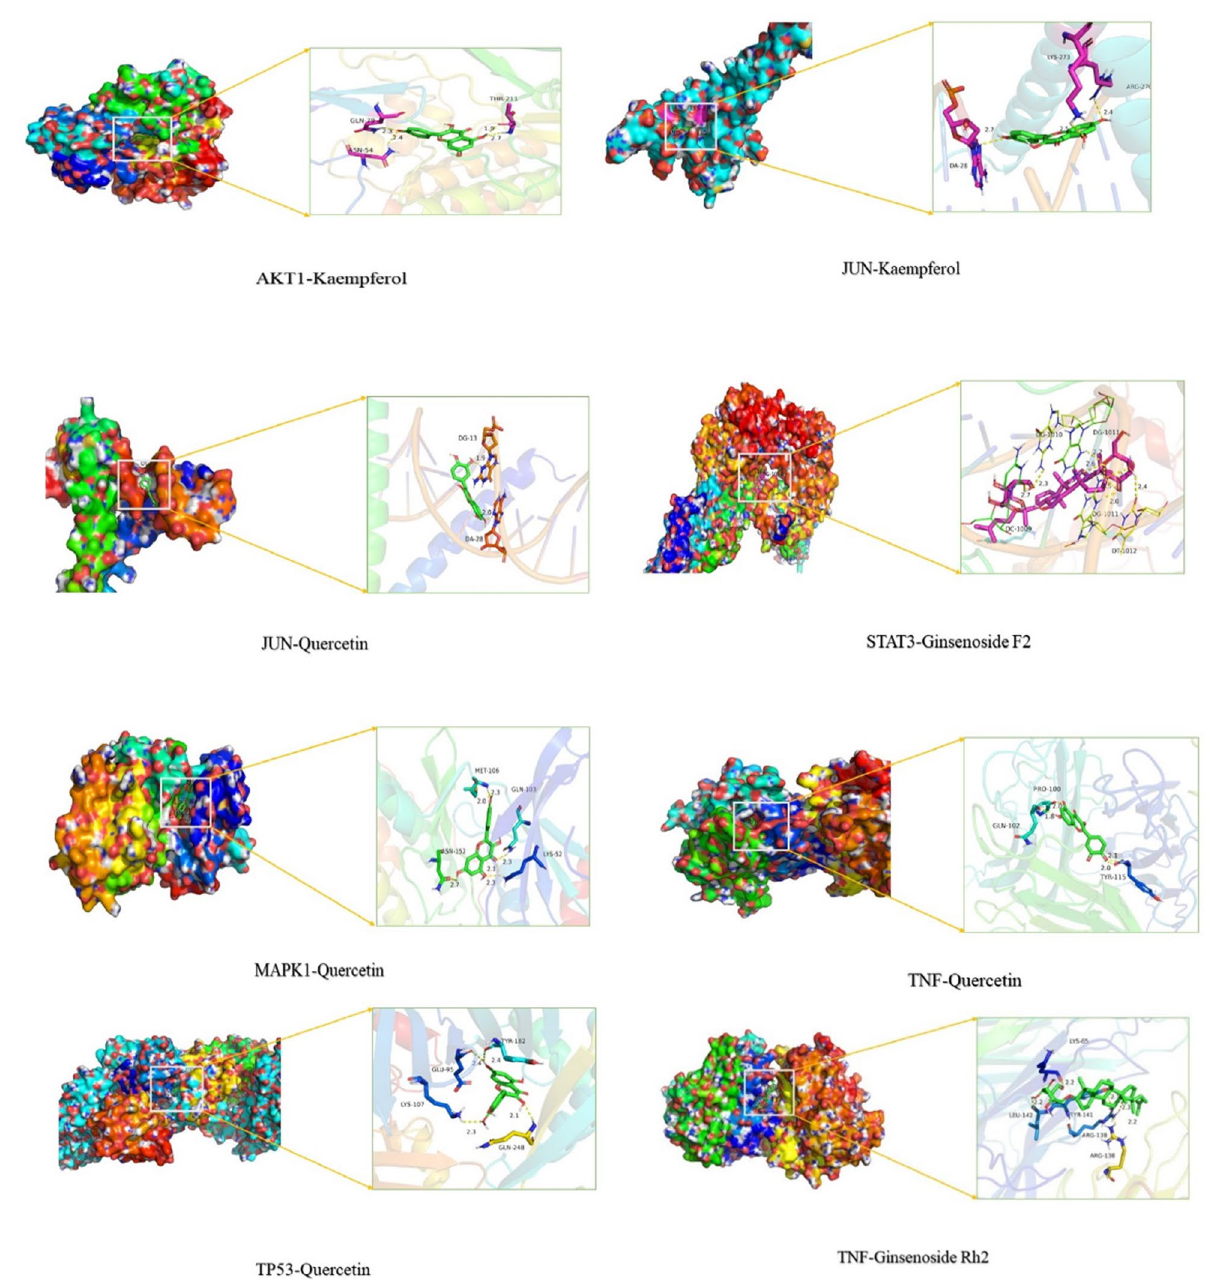
Figure 7. Detailed target-compound